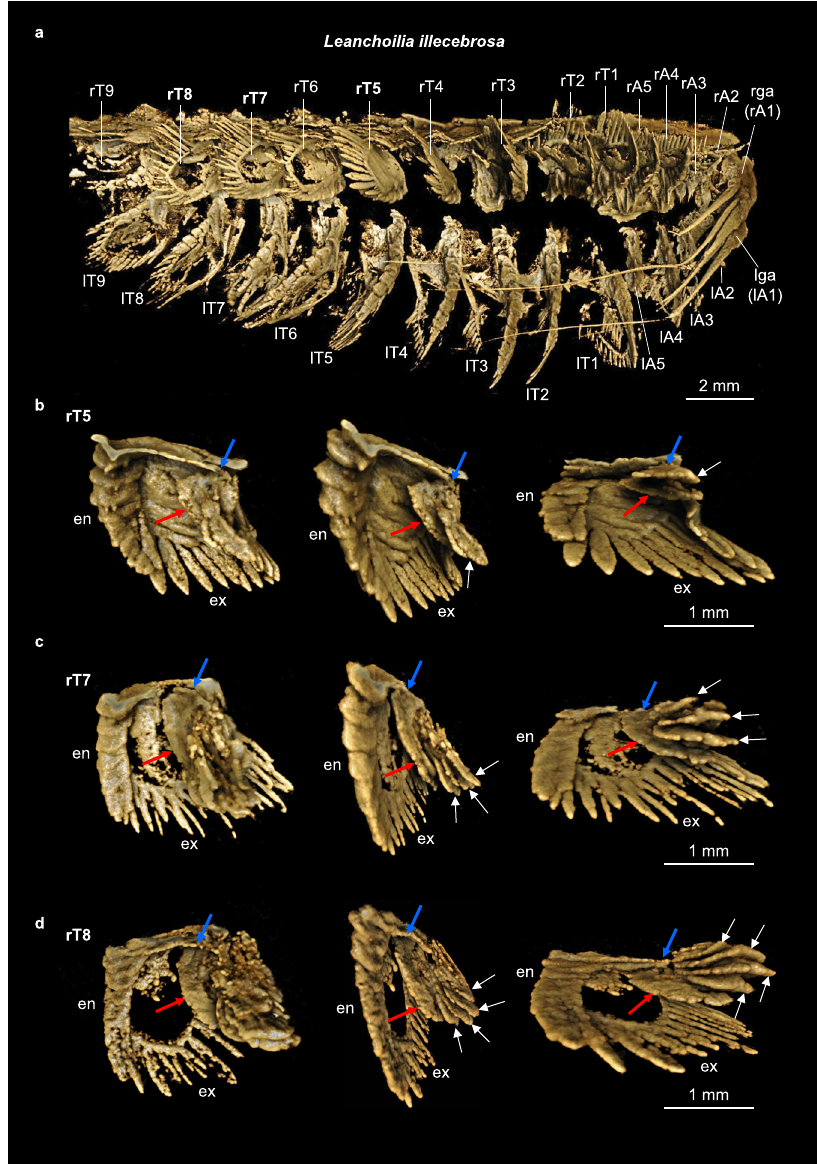
Fig. 1 Computed tomographic images of YKLP 11424 showing selected exite-bearing appendages of Leanchoilia illecebrosa . a Ventral side of the animal. b – d Digitally dissected trunk appendages 5, 7, and 8 from the right side of the animal (rT5, rT7, rT8). Each appendage is shown at three different angles to demonstrate the endopodite (en), the exopodite (ex) and the exite consisting of one basal fl ap (red arrow) and several additional ones (white arrows). Blue arrows point to the attachment of the exite. Individual scale bars provided. A n , head appendage n ; l, left; r, right; ga, great appendage; T n , trunk appendage n . Dissections of all appendages are available in Supplementary Figs. 2 –